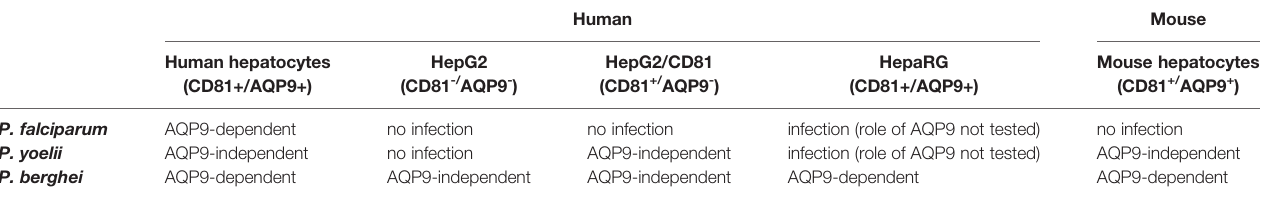
TABLE 1 | Summary of the role of AQP9 in susceptibility to Plasmodium infection according to the different cell types and plasmodial species tested on the basis of RNA silencing experiments. Human